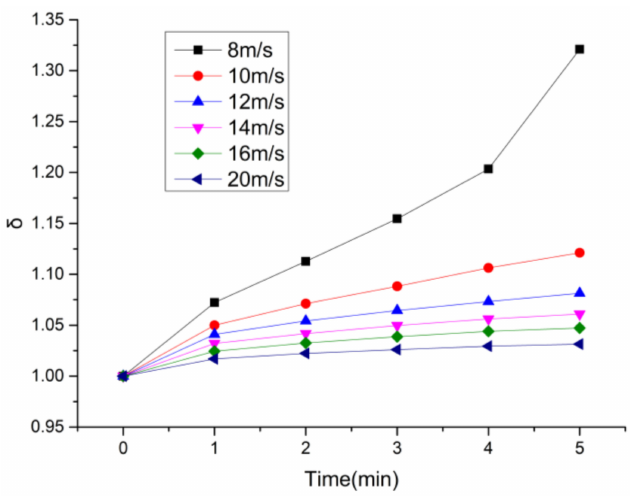
Figure 20. At different flow